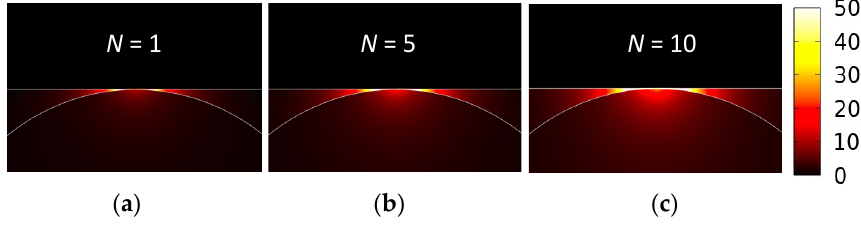
Figure 4. Mode fields of | E | for N = ( a ) 1, ( b ) 5, and ( c ) 10 at the same parameters as in Figure 3. Figure 5a,b also show 1D field plots along the horizontal dashed line H (inset of Figure 5a) and vertical dashed line V (inset of Figure 5b), respectively, to more clearly observe the relative mode profiles for different N values. The ultrasmall A m = 10 − 6 of the present design shows full widths at half maximums of approximately 1 and 0.1 nm along the x and y directions, respectively. The L p can be attributed to the mode profile being significantly shifted from the region of MLGMTs to the Si nano-rib as N increases (see Figure 5b). Note that the conditions E F = 0.6 eV, N = 10, and f = 20 THz are used in subsequent analyses unless stated otherwise.